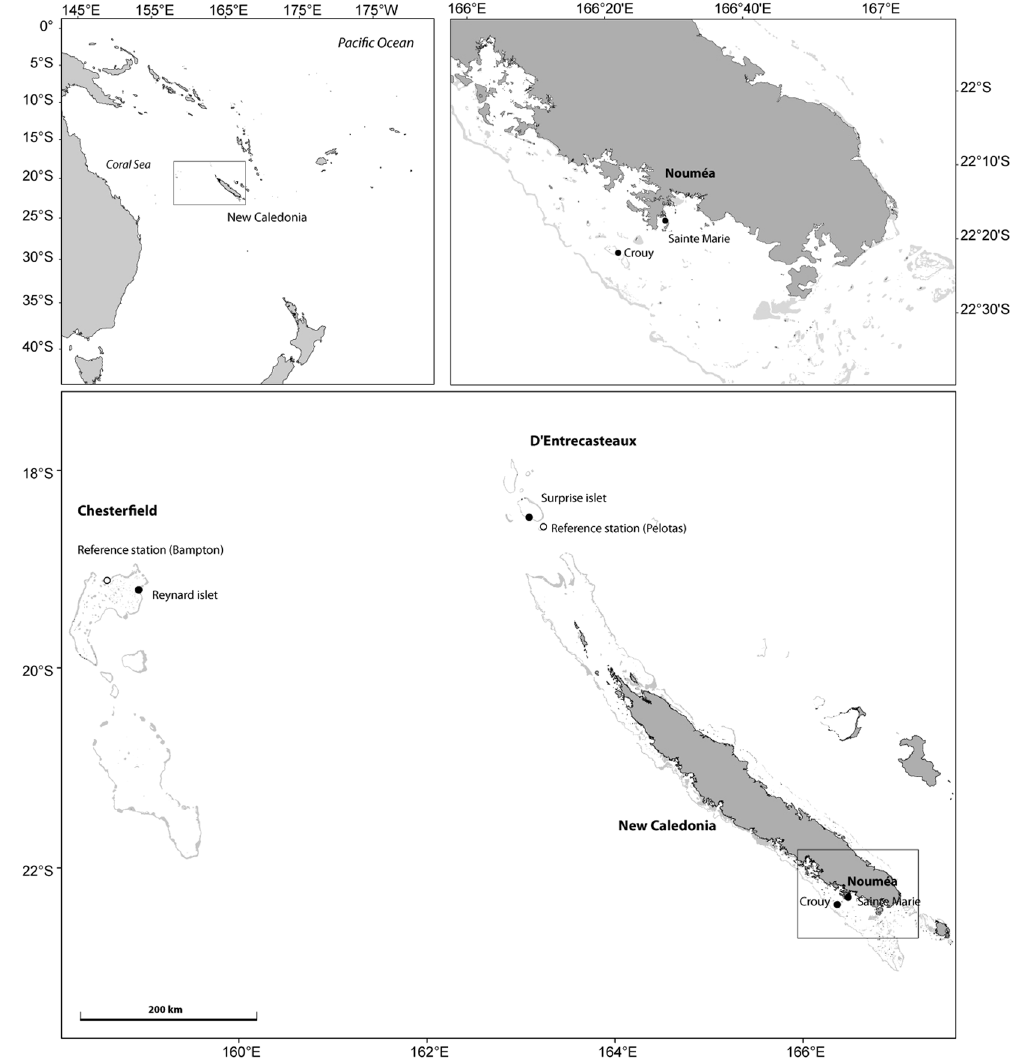
Figure 1. Sampling sites in New Caledonia. The map was generated with ArcGIS 10.2.2 (http://www.esri.com/ arcgis/aboutarcgis) and customized in Adobe Illustrator CS3 (version 13,